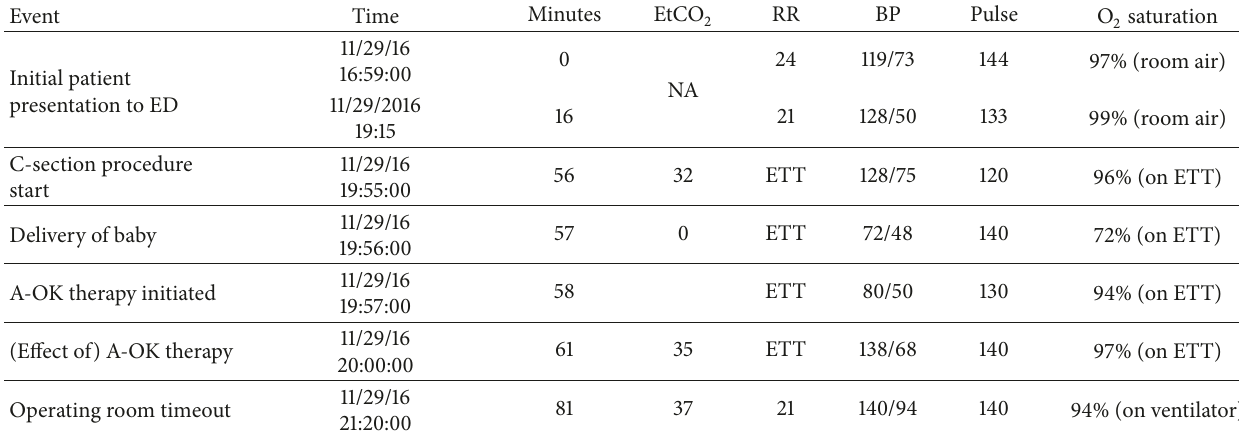
Table 2: Patient vital signs as demonstrated in Figure 2.